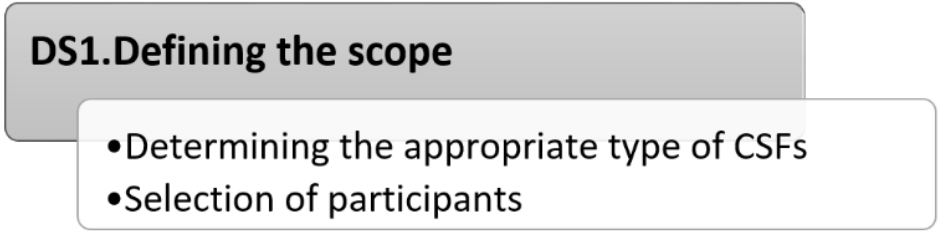
Figure 2. Design of CSFs: Stage 1.